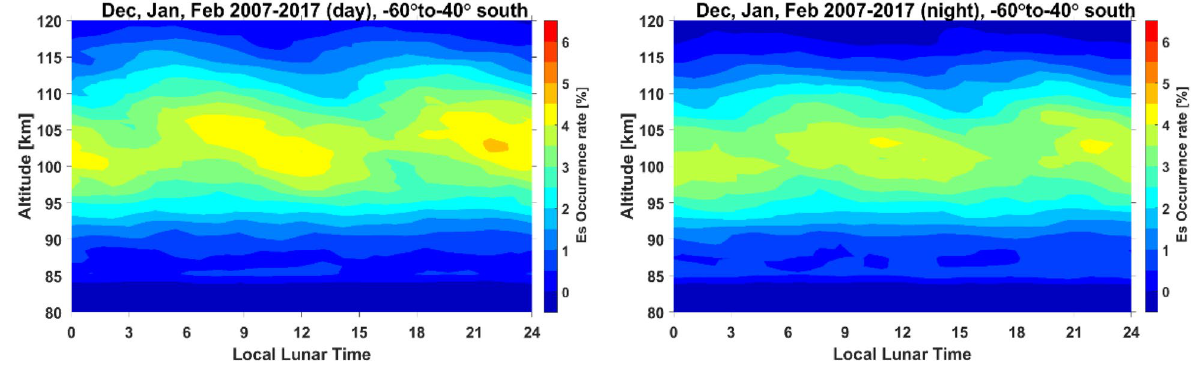
Figure a Mid-latitude EsOR variations during northern hemisphere summer with lunar local time at day (left) and night (right).